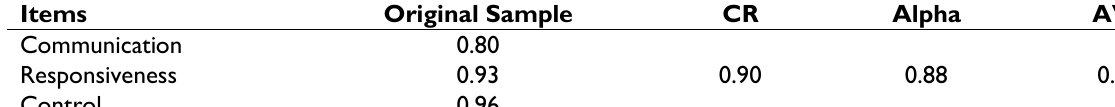
Table 4. 2 nd Order Reliability and Convergent Validity Test Result